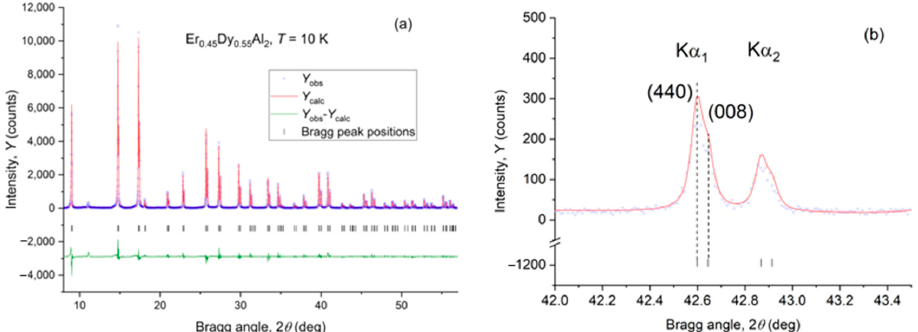
Figure 4. ( a ) The Rietveld refinement of the X-ray powder diffraction pattern of the Er 0.45 Dy 0.55 Al 2 measured at 10 K using tetragonal model (R p = 10.7%, R B = 4.8%). A weak Bragg peak at ~11 deg 2 θ is